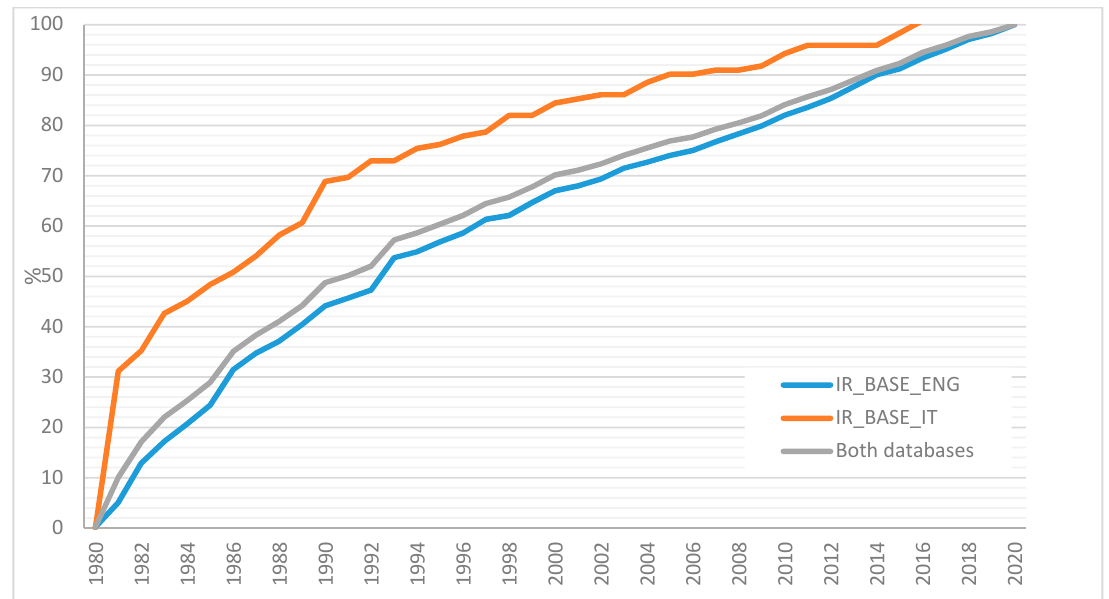
Figure 3. Cumulative percentage of yearly documents in the two databases taken both separately and as a whole.